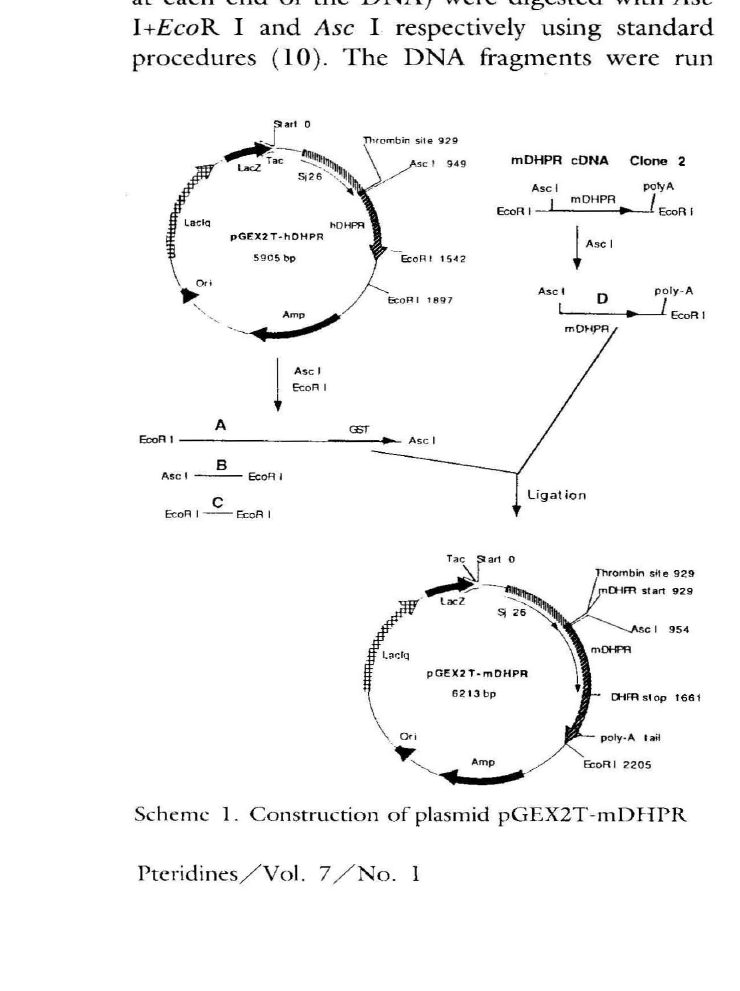
Scheme I. Construction of plasmid pGEX2T-mDHPR Ptcridines/ Vol. 7/ No.